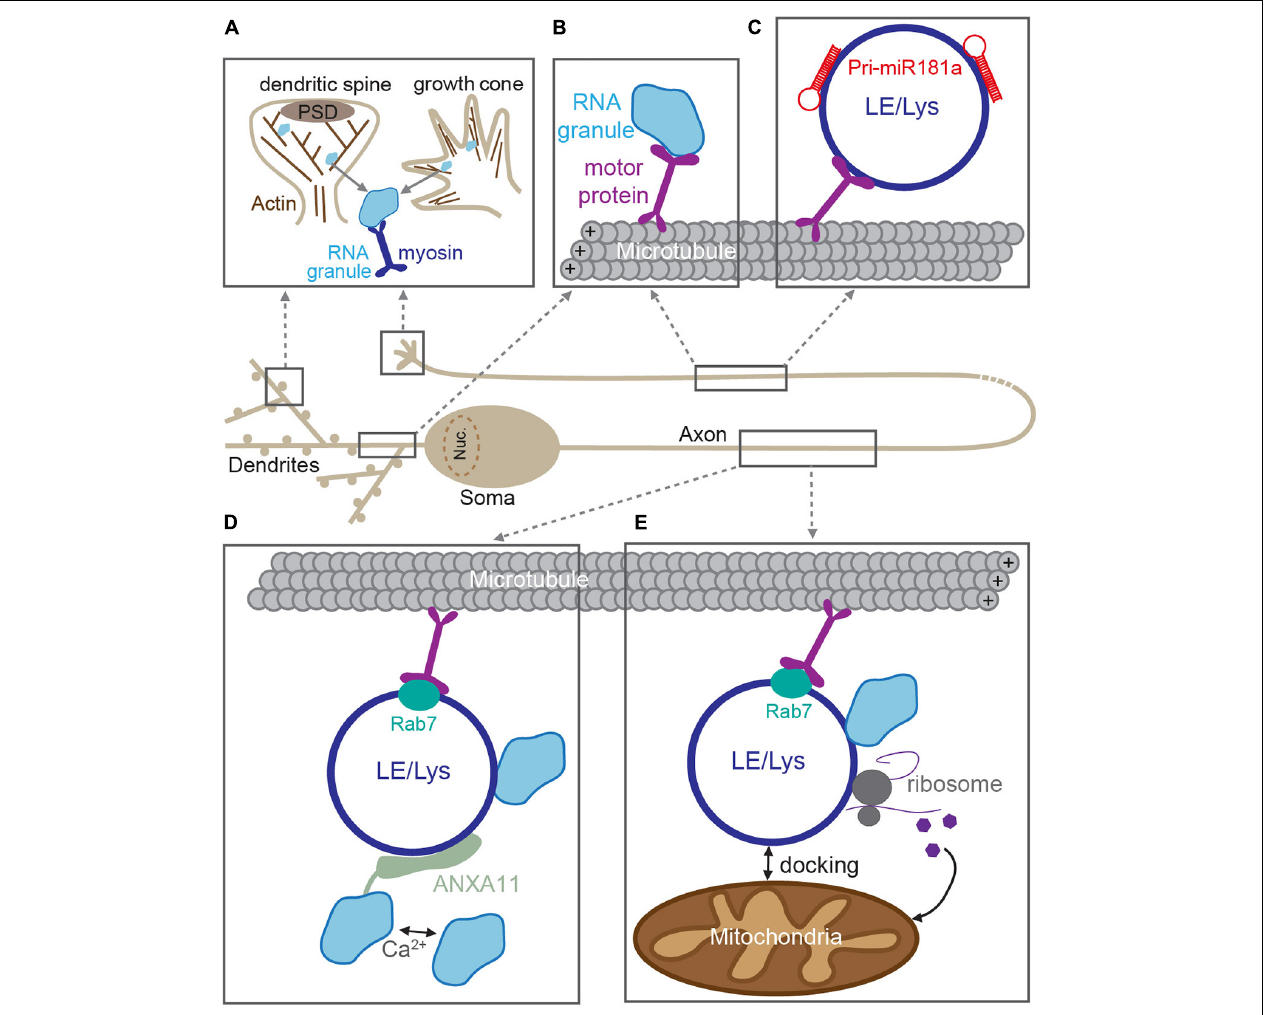
FIGURE 2 | RNA trafficking along neuronal processes. RNAs are incorporated into RNA granules and transported through dendrites and axons along cytoskeletal tracks. (A) In dendritic spines and growth cones, RNA granules are transported along F-actin filaments by myosin motors. (B) In dendrites and axons, RNA granule active-transport is mediated by kinesin and dynein motors along microtubules. Transport can be mediated through direct association between RNA granules and motors. In axons, RNA granules are transported through indirect association via membranous compartments such as late endosomes or lysosomes (LE/Lys) (C–E) . (C) Pre-miRNAs are trafficked to developing growth cones via direct interactions with LE/Lys (Corradi et al., 2020). (D) LE/Lys act as a vesicular transporters for RNA granules. RNA granules are tethered to the rab7-positive LE/Lys via a Ca 2 + -dependent interaction with the adaptor ANXA11 (Liao et al., 2019). (E) Rab7-positive LE/Lys transport RNA granules and translational machinery along microtubules and can dock at mitochondria, and produce proteins required for mitochondrial function (Cioni et al.,